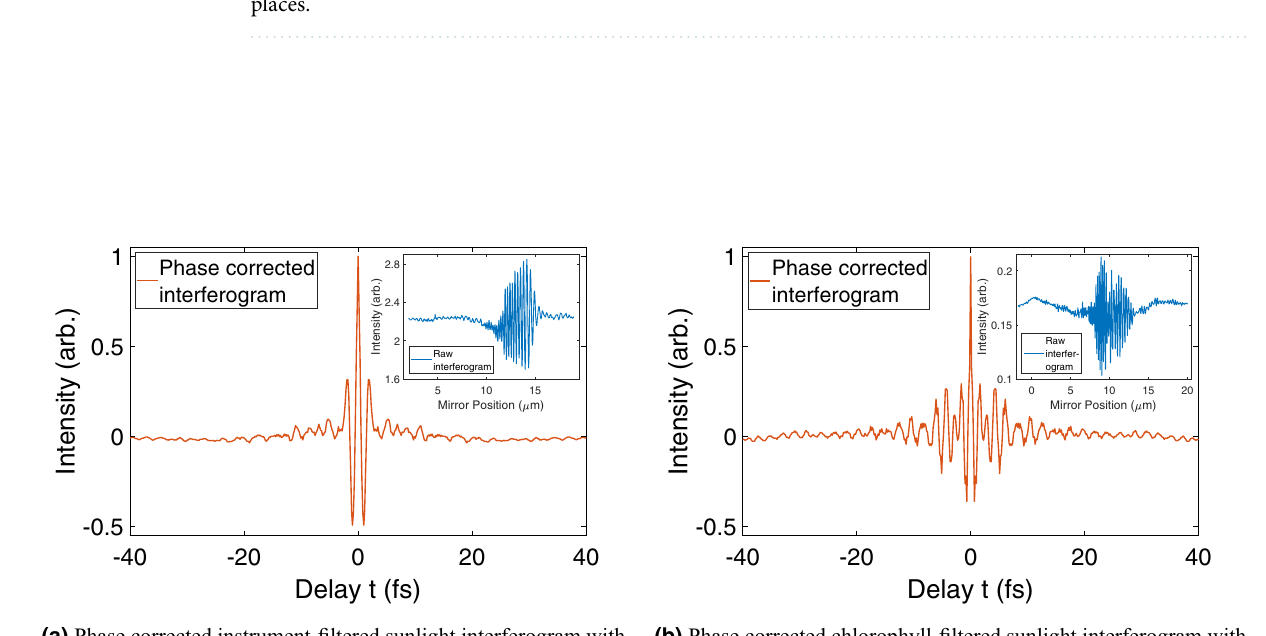
Table 1. Coherence time of sunlight: experimental vs. theory. The error for the experimental values are calculated as the standard uncertainty of the mean from 30 and 24 measurements collected between August 2019—September 2020 in Edinburgh, Scotland for the instrument-filtered and chlorophyll-filtered cases, respectively. �τ Wolf and �τ Mandel are calculated using Eqs. (2a) and (2b), respectively. For the theoretical calculations, a black-body temperature of 5777 K was used. All values have been rounded to two decimal places.